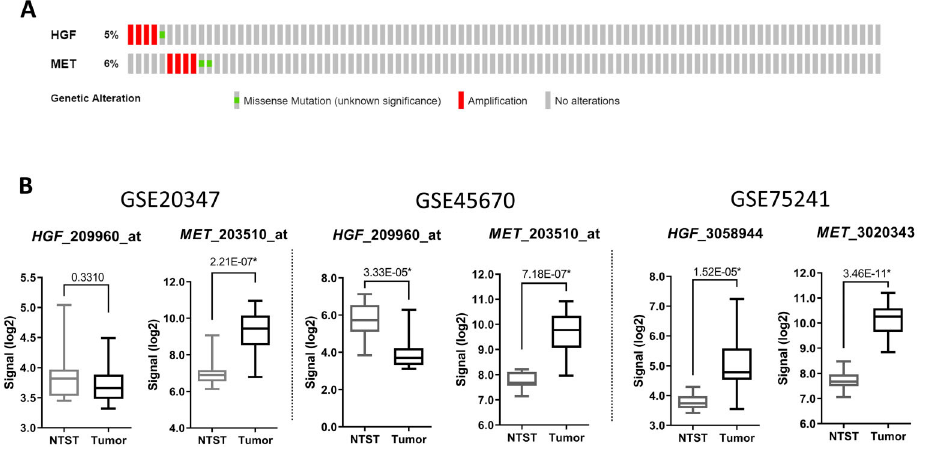
Figure 1. Hepatocyte growth factor (HGF) and MET molecular alterations in publicly available datasets. A , OncoPrint chart showing copy number alterations and mutations identi fi ed in esophageal squamous cell carcinoma (ESCC) cases from TCGA Firehose Legacy study. Each bar represents a case. B , Boxplots showing the expression pro fi le of HGF (probe 209960_at or 3058944) and MET (probe 203510_at or 3020343) in three publicly available datasets of ESCC samples and non-tumor surrounding tissues (NTST) (GSE20347, GSE45670, and GSE75241). Datasets GSE20347 and GSE45670 used Affymetrix Human Genome U133 Plus 2.0 and dataset GSE75241 used Affymetrix Human Exon 1.0 ST Array. Data are reported as medians and interquartile range. *FDR o 0.05